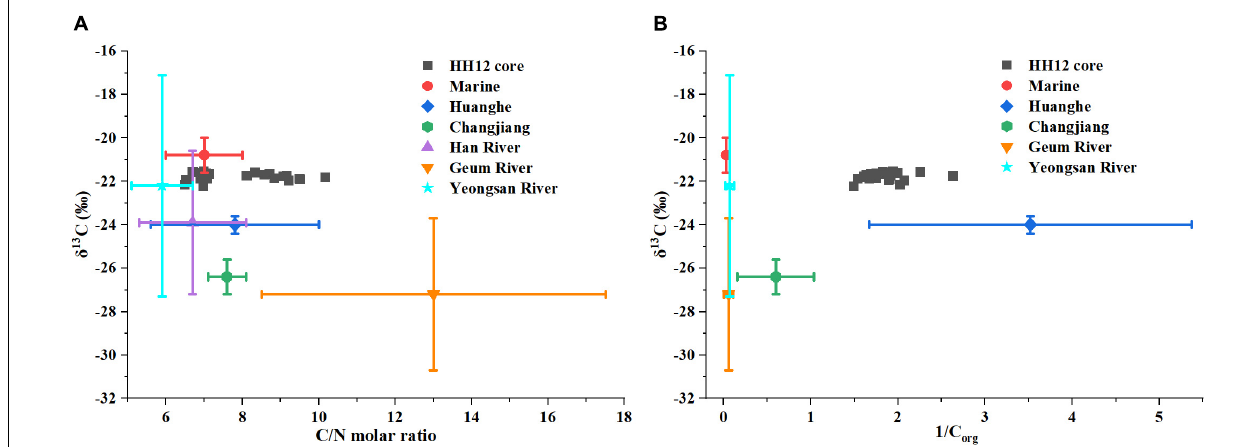
FIGURE 5 | Cross-plots of δ 13 C versus C/N molar ratio (A) and 1/C org (B) . Endmembers values used in this figure are as follows: POC- δ 13 C, 1/C org and C/N endmembers of the modern Huanghe are from Tao et al. (2015) and Yu et al. (2019a); POC- δ 13 C, 1/C org and C/N endmembers of the modern Changjiang are from Wu et al. (2018) and Sun et al. (2021). POC- δ 13 C, 1/C org and C/N endmembers of the modern Geum River, Youngsan River and Han River are from Kang et al. (2019); Lee et al. (2013) and Yoon et al. (2016), respectively. POC- δ 13 C, 1/C org and C/N endmembers of the marine source are from Redfield et al. (1963), Müller (1977), Hedges et al. (1997), Blair and Aller (2012), Kao et al.